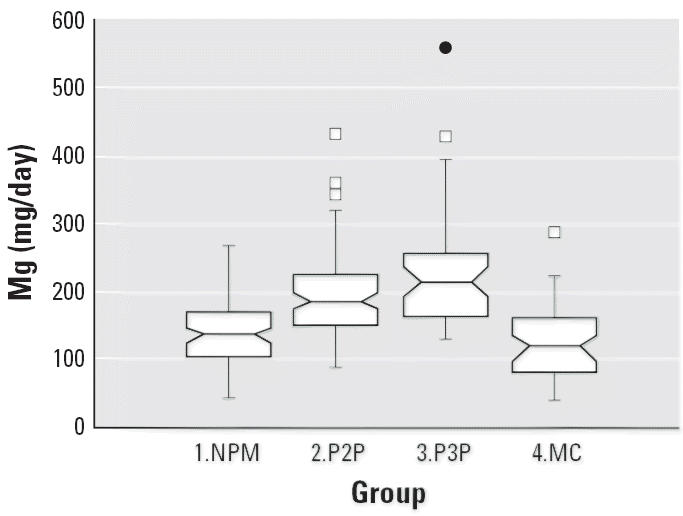
Notched box plot for descriptive statistical data showing daily intakes
of Mg from 6-day duplicate diets. The recommended daily intake for such
females is 340–355 mg Mg (National Research Council 1989).